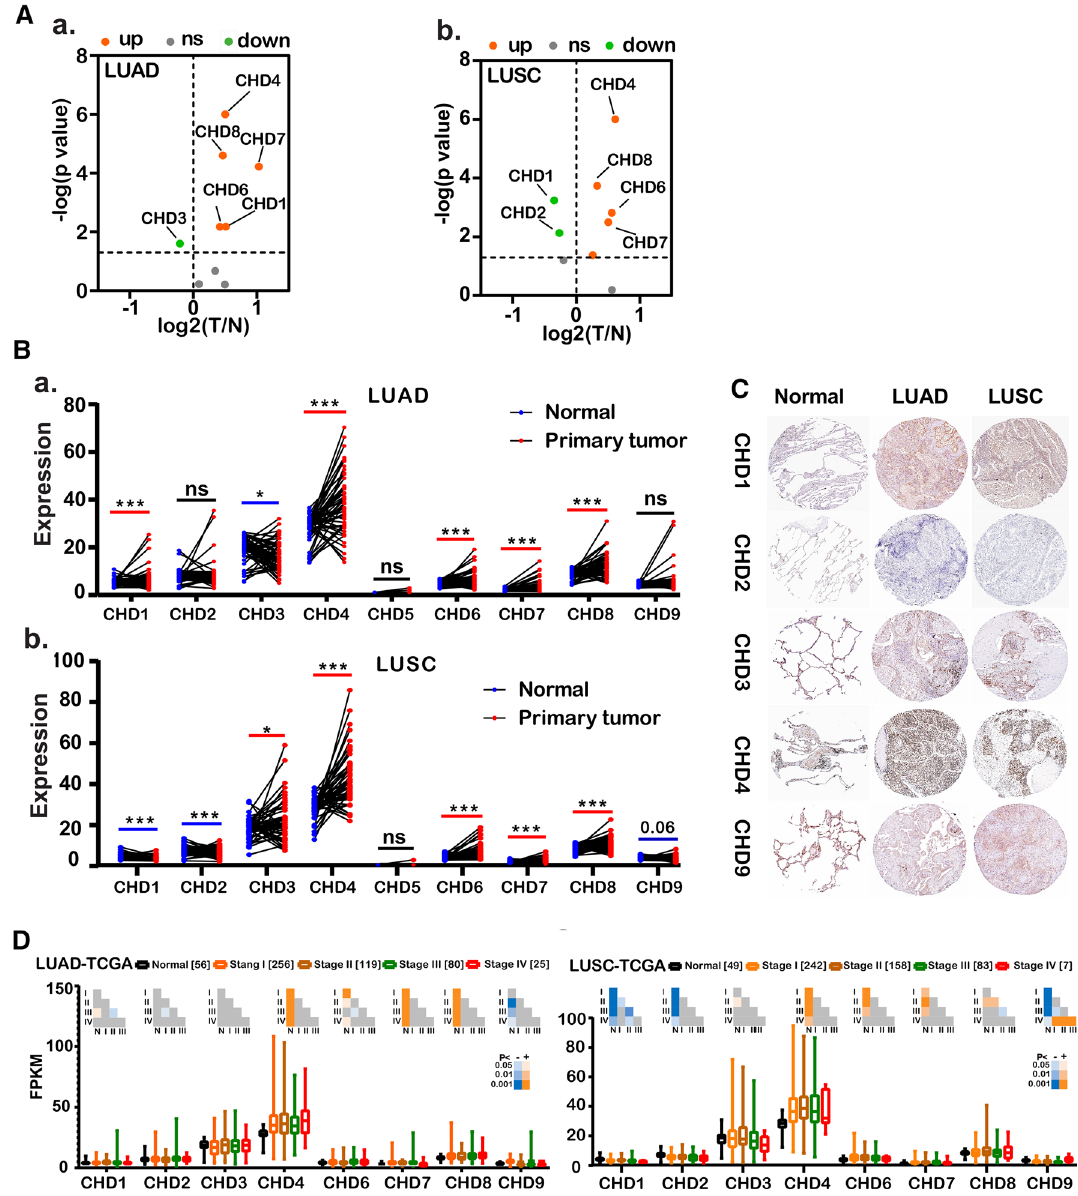
Fig. 1 Aberrant expression of CHDs in lung cancer. A Vocano plots illustrating differential changes in CHDs in lung adenocarcinoma versus normal tissues from TCGA database; b Vocano plots illustrating differential change of CHDs in lung squamous cell carcinoma versus normal tissues from TCGA database. Values are presented as log2. Gray, p > 0.05; Green, p < 0.05; Orange, p < 0.05;. T, primary tumor. N, normal tissue. LUAD, lung adenocarcinoma, LUSC, lung squamous cell carcinoma. B a mRNA expression of CHDs in 56 paired lung adenocarcinoma and adjacent normal tissues from the TCGA database; b 49 paired lung squamous cell carcinoma and adjacent normal tissues from the TCGA database. *p < 0.05, **p < 0.01, ***p < 0.001. C Representative immunohistochemistry images of CHDs in lung cancer and normal lung tissues (Human Protein Atlas). Left panel, normal lung tissues. Middle panel, LUAD. Right panel, LUSC. D Boxplot showing the association between CHD expression and tumor